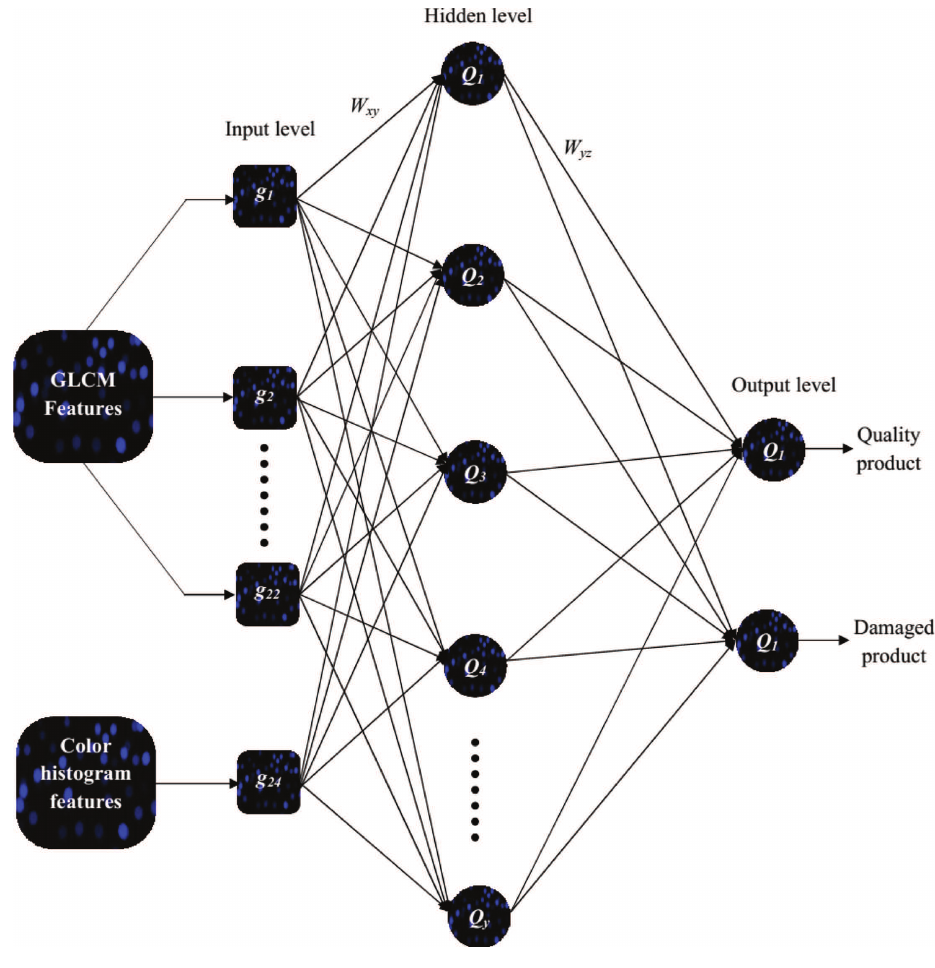
Figure 3: Structure of